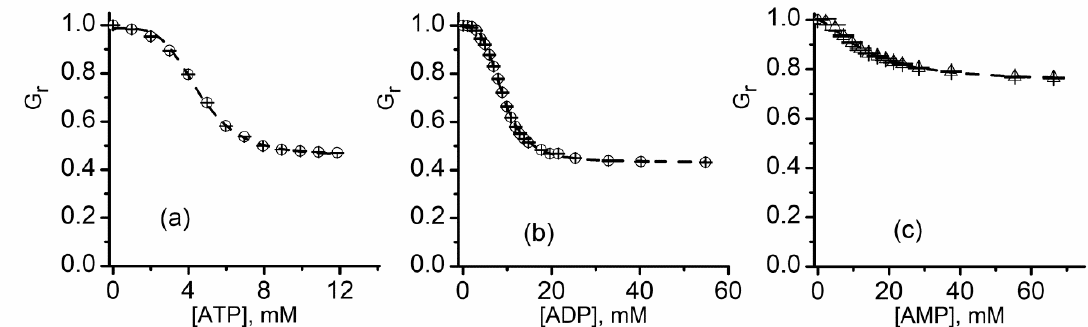
Figure 14. Changes in relative conductance induced by addition of ATP, ADP, or AMP. The relative changes in macroscopic conductance G r show that ATP ( a ) and ADP ( b ) were more efficient inhibitors compared to AMP ( c ). The dashed lines in each panel represent the fit with the Hill equation, which is used to determine IC 50 and n . Adapted from [59], with